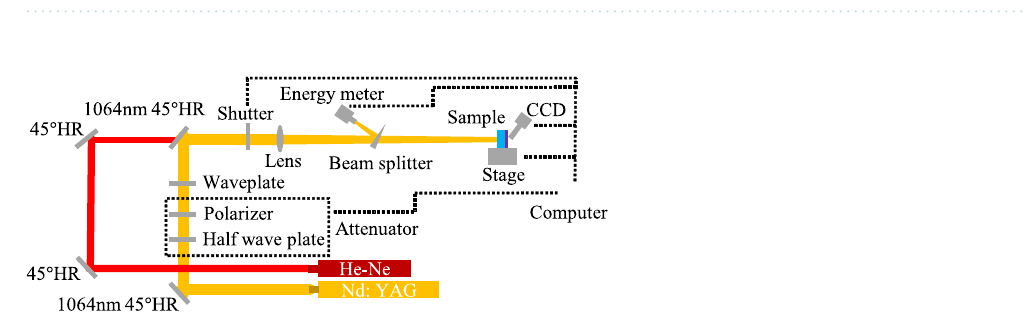
Table 1. Three groups of coatings.